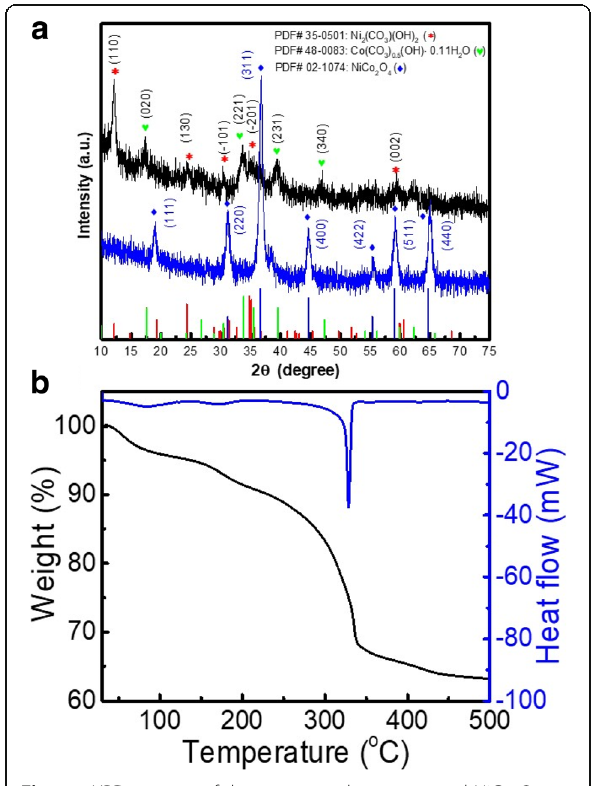
Fig. 1 a XRD patterns of the as-prepared precursor and NiCo 2 O 4 product before and after heat treatment at 450 °C. b TGA analysis of precursor under oxygen atmosphere with a heating rate of 10 °C min −